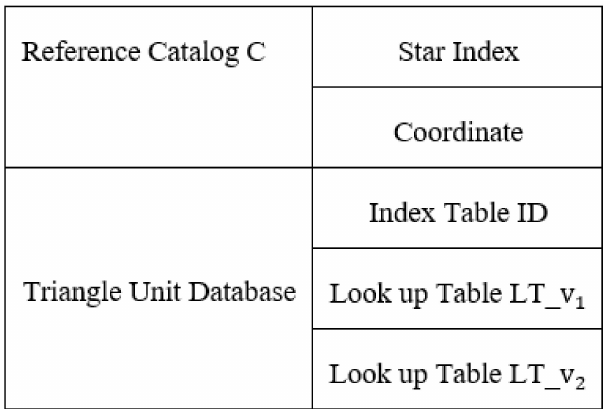
Figure 2. Structure of onboard